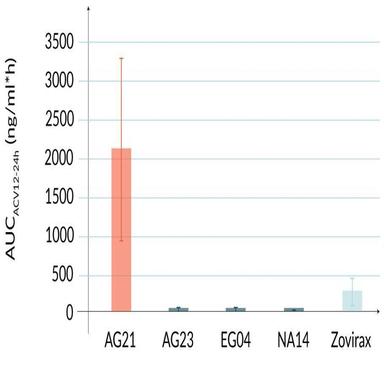
AUCACV 12-24h for four selected test formulations and Zovirax® 5% cream (mean ± SD).